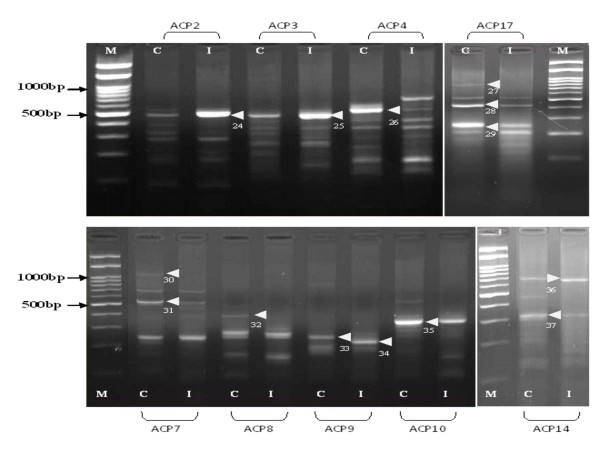
There are 14 bands, of which 4 of them are up regulated and 10 down regulated. The identities of these bands are presented in Table 5. M: 100 bp molecular marker; C: Control lung tissue; I: Lung tissue infected with H5N1. Arrow indicates differential cDNA bands and each number indicates the DEG number.